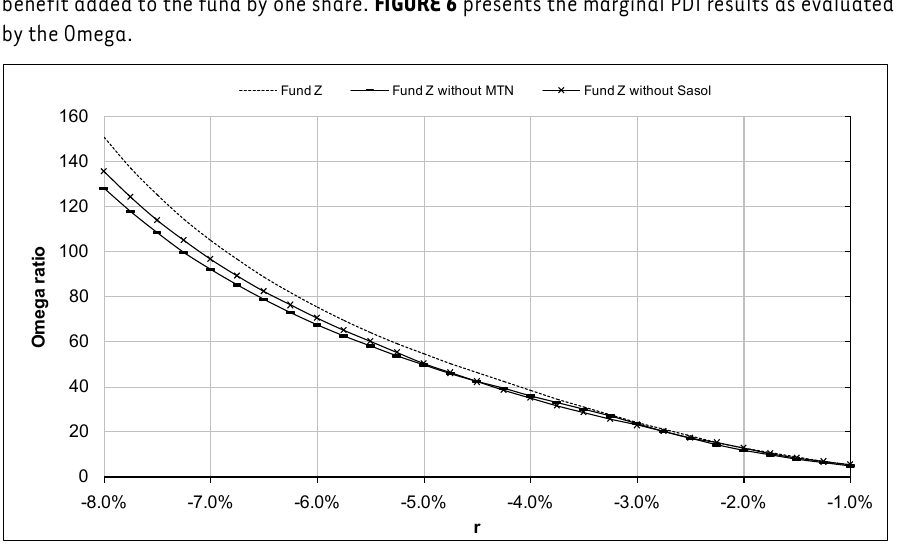
FIGURE 6: Marginal PDI Source: Compiled by